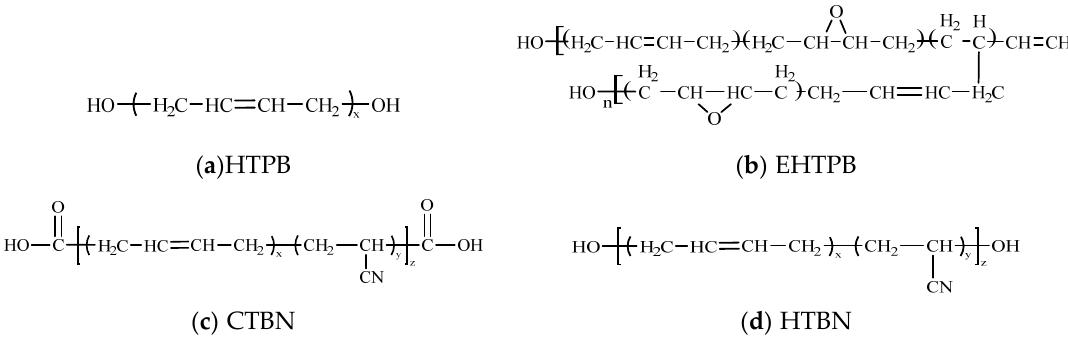
Figure 1. Molecule structures of the four kinds of liquid rubbers. ( a ) hydroxyl-terminated liquid polybutadiene (HTPB); ( b ) epoxidized hydroxyl-terminated liquid polybutadiene (EHTPB); ( c ) carboxyl-terminated liquid nitrile-butadiene rubber (CTBN); ( d ) hydroxyl-terminated liquid nitrile-butadiene rubber (HTBN).